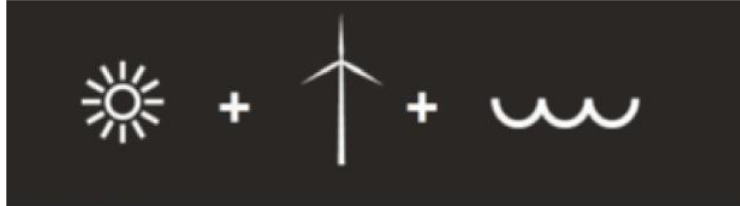
Fig. 11: the use of natural resources, wind, sun and water, to achieve energy optimization purposes (BIG, 2010)